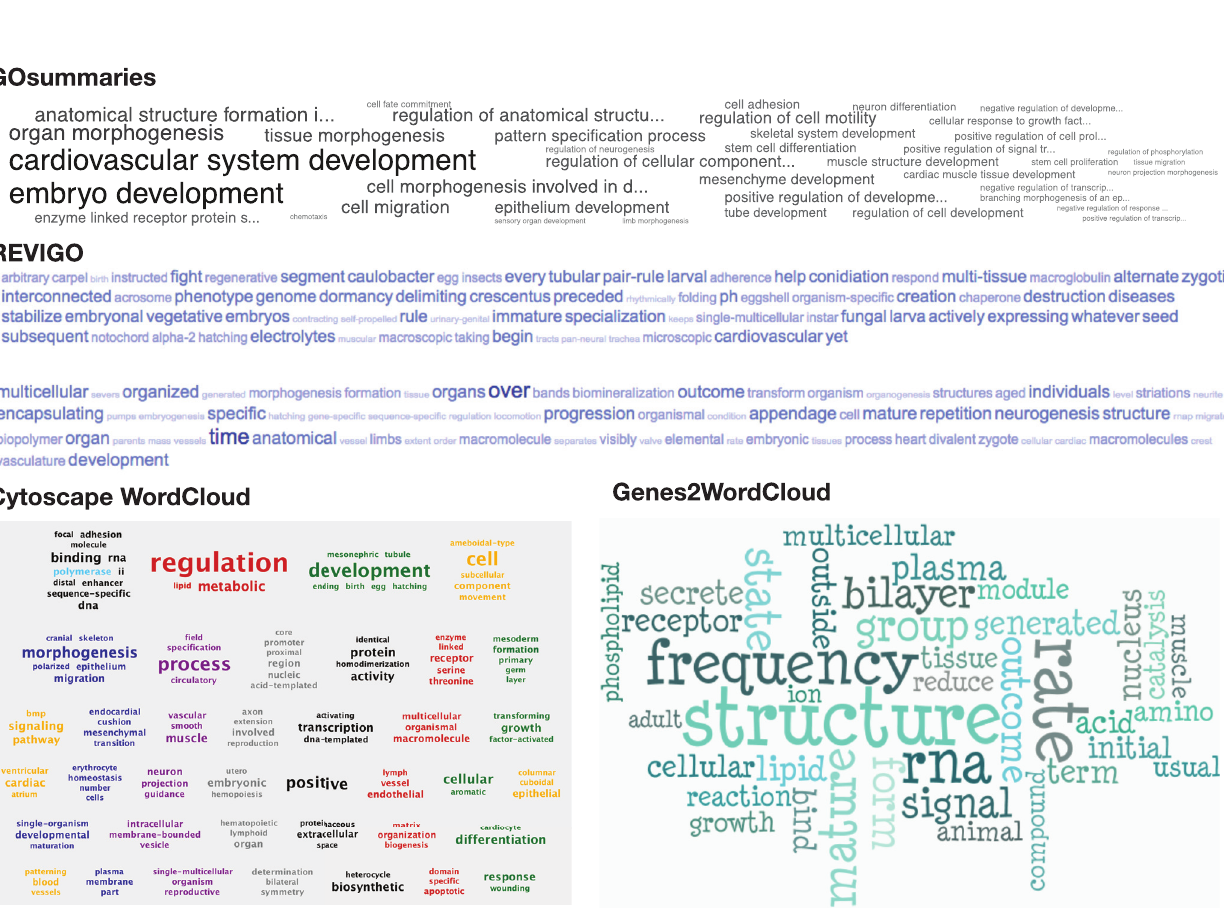
the figure. The genes that are related to stem cell maintenance are